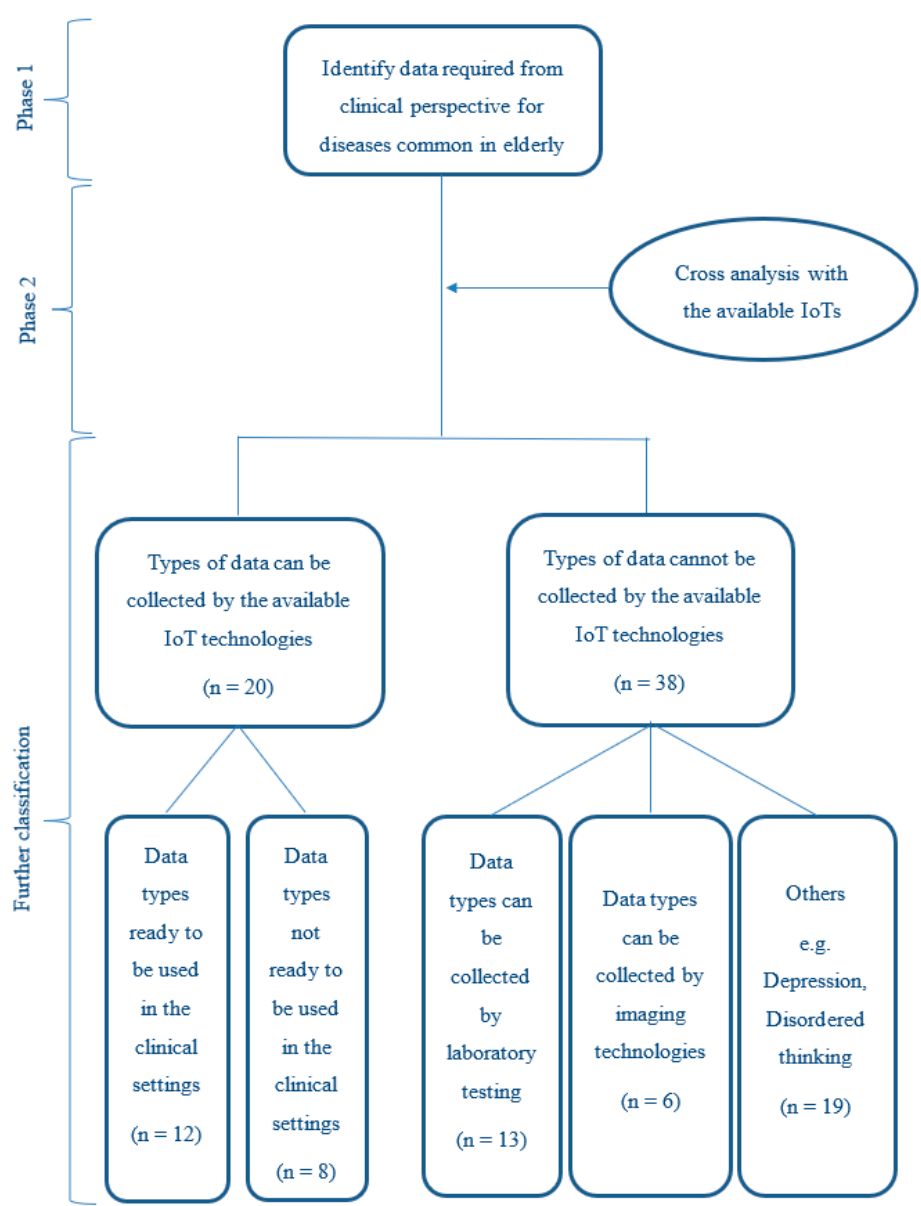
Figure 1. The overall research approach.